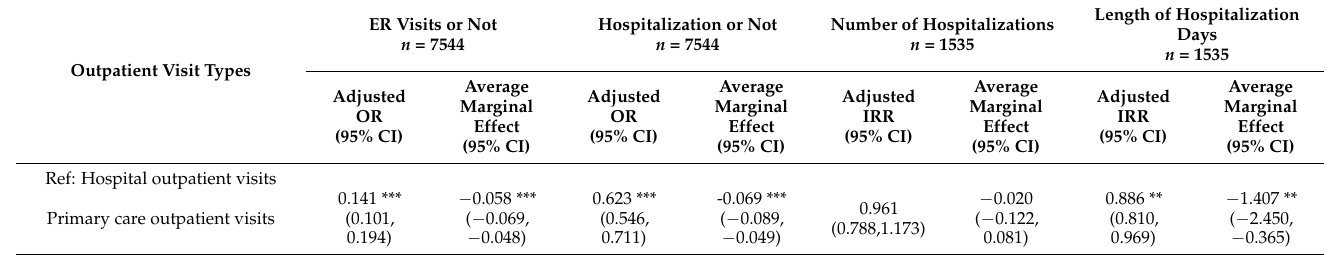
Table 4. Association between the outpatient visit types and ER or hospital inpatient services utiliza- tion among middle-aged and elderly Chinese